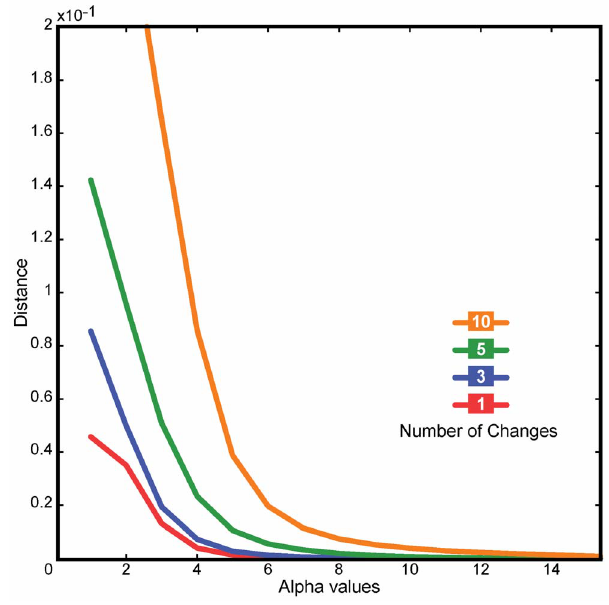
Figure 2. Similarity score for a sequence compared with modified versions of itself using different values of a . A 10,000 nt random sequence was created. Using this sequence as a template, a second was created that included one random substitution. The remaining sequences were built based on the last created sequence, adding new random substitutions. The result was an original sequence and four mutated sequences bearing 1, 3, 5, and 10 cumulative substitutions. The original sequence was then compared with each mutated sequence using different a values.